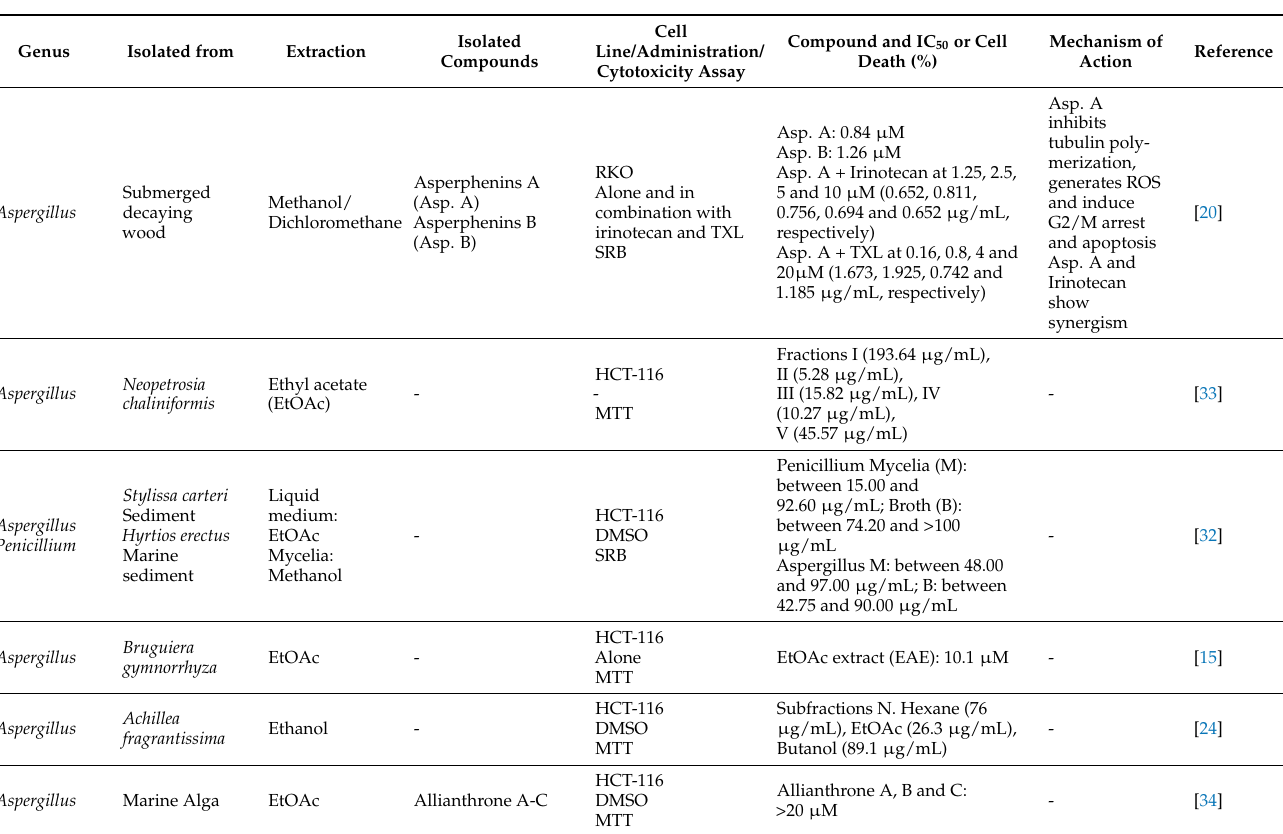
Figure 2. Mechanisms of action through which the different fungi of Ascomycota perform their effect as against CRC. Table 1. Antitumor activity of the extracts or isolated compounds from Eurotiales order in CRC cancer cell